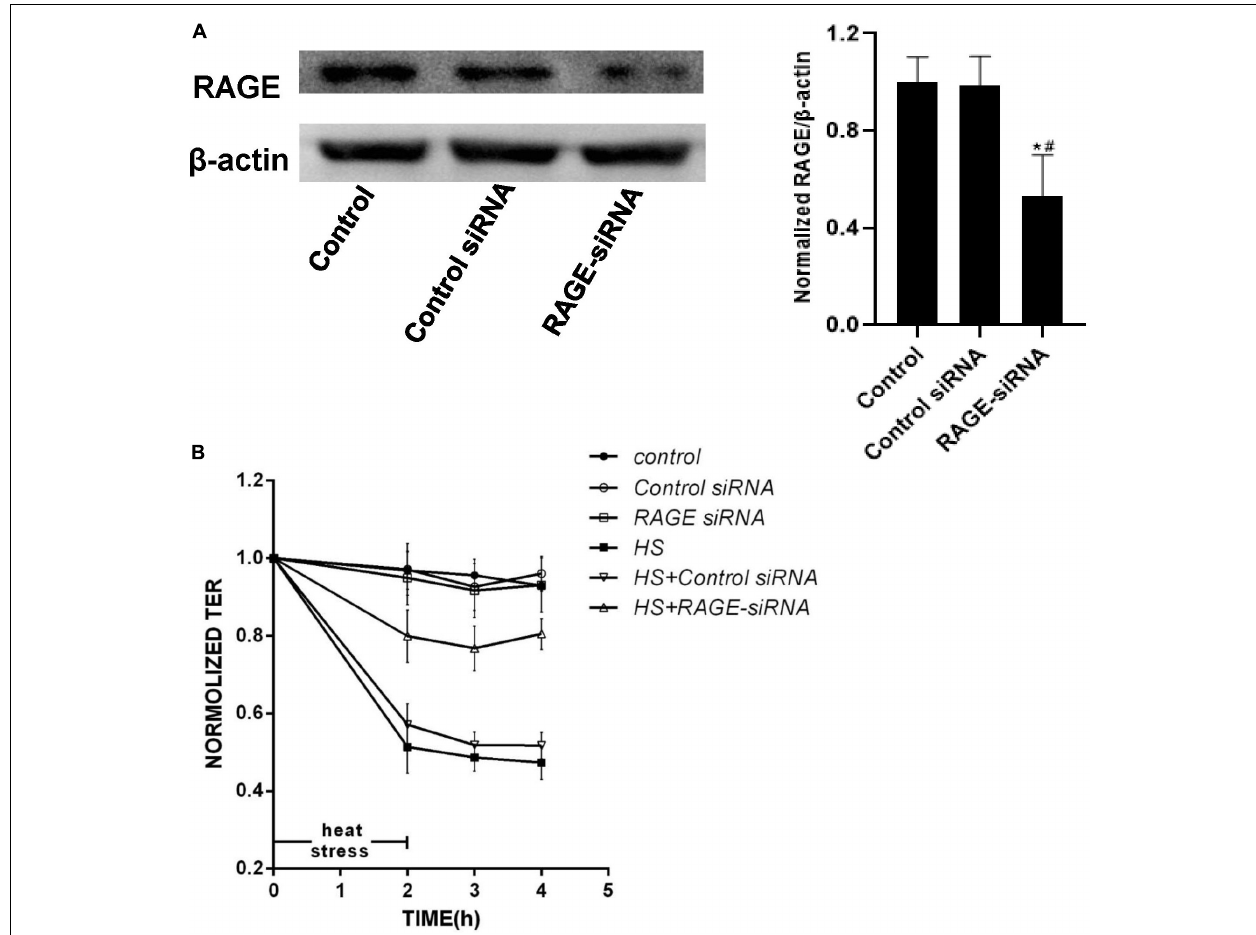
FIGURE 4 | Knockdown of expression of RAGE by siRNA prevented increased permeability induced by heat stress. (A) HUVECs were transfected with RAGE siRNA. After 48 h, total proteins were extracted and the expression of RAGE protein was detected by western blot. (B) HUVECs treated with either control or RAGE siRNA were subjected to heat stress at 42 ◦ C for 2 h. TEER was recorded before (used as a baseline) and after heat Stress. Transfection with RAGE siRNA decreased the hyperpermeability induced by heat stress (* P < 0.05 vs control group, # P < 0.05 vs control siRNA group).